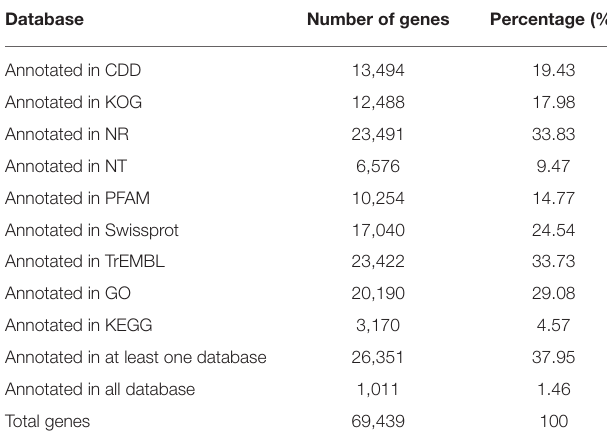
TABLE 3 | Percentage of annotated